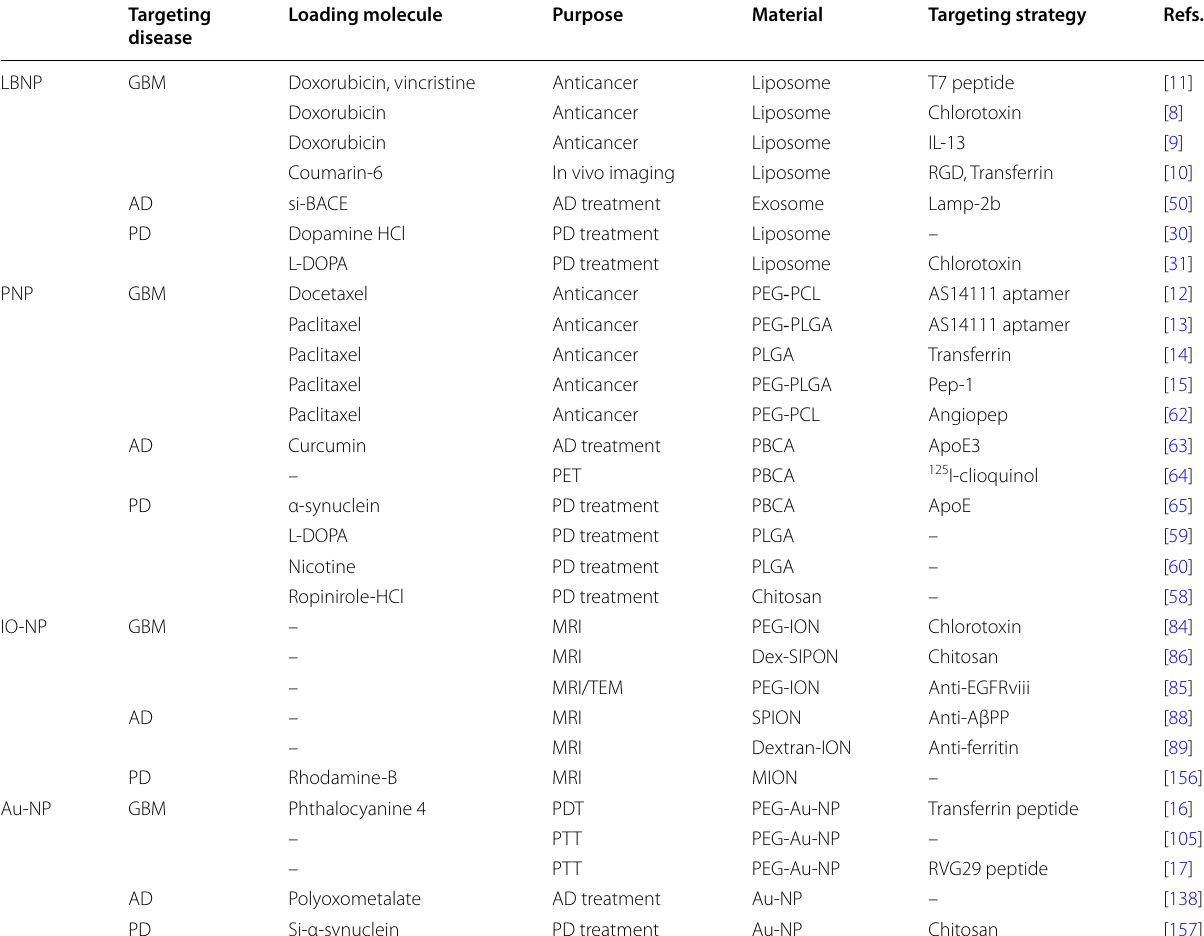
Table 2 List of nanomedicines targeting CNS diseases Targeting Loading disease